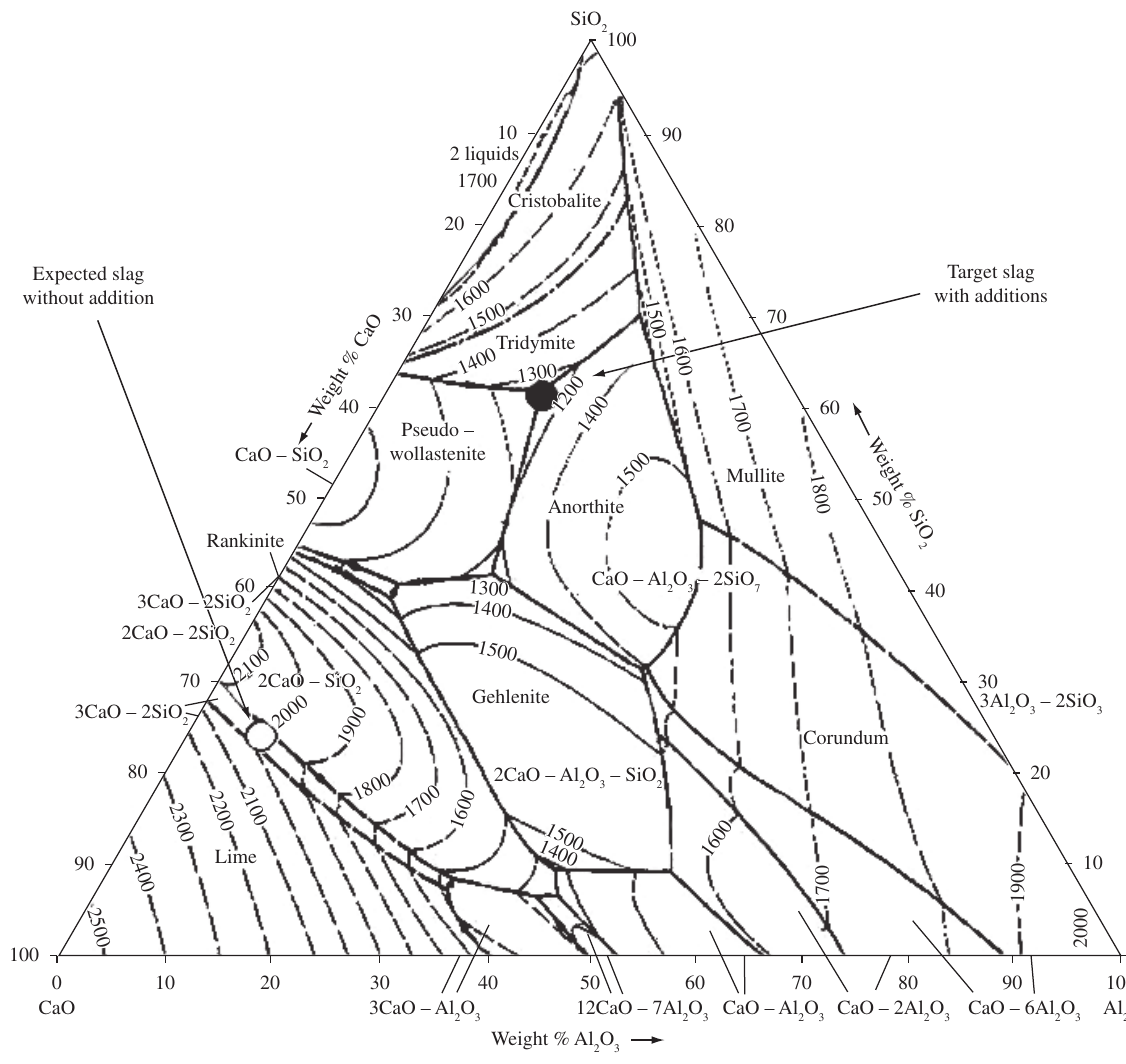
Figure 1. Liquidus temperatures of the CaO-SiO2-Al2O3 system and the expected slags without and with additions 9 .